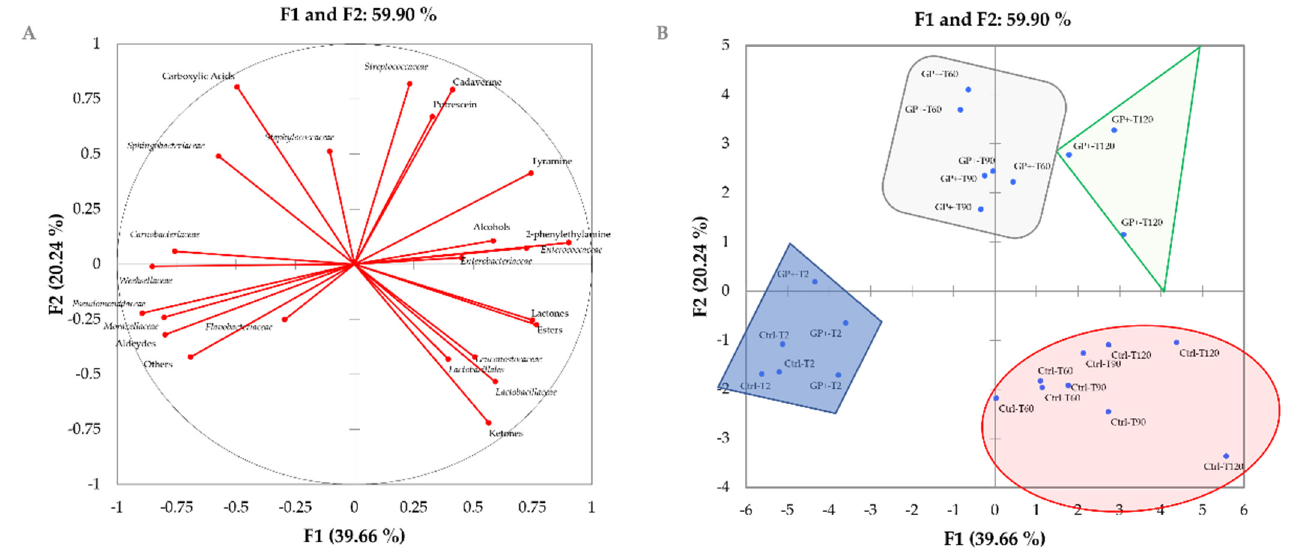
Figure 3. Score plot ( A ) and loading plot ( B ) of the principal component analysis among bacteria families, volatile compounds and biogenic amines in cheese samples after 2 (T2), 60 (T60), 90 (T90) and 120 (T120) days of ripening obtained from raw milk of ewes fed standard diet (Ctrl) and grape pomace diet (GP+).